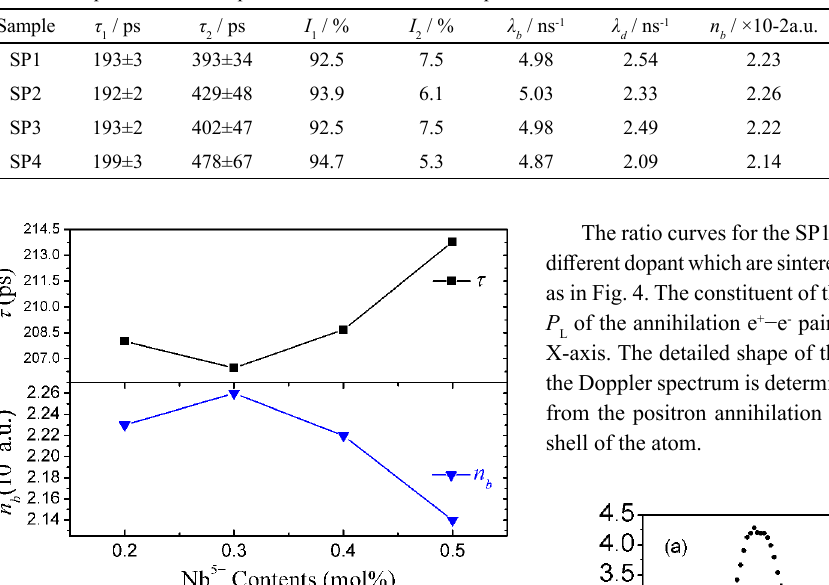
Figure 3. The average lifetime τ of the positrons and the free electron density n in the BSTN samples is as a function of the Nb b